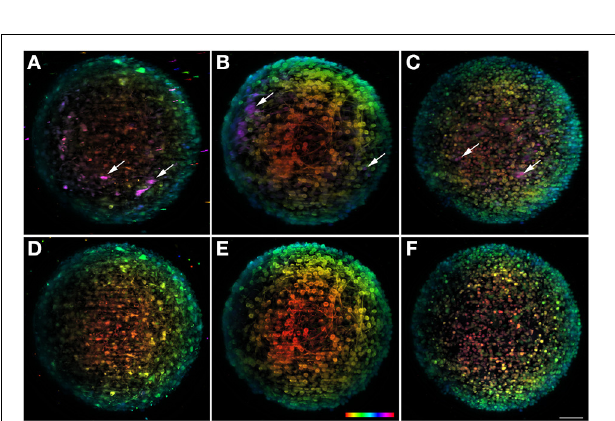
Neural aggregate #2 showing a complex dopaminergic neuron matrix at: (E) 29 μ m from surface; (F) 59 μ m and (G) 97 μ m. (H) Maximum intensity projection of the dopaminergic neuronal matrix. Sagittal views of (I) Neural aggregate #1 and (J) Neural aggregate #2. A full 3D representation of the dopaminergic neurons is shown in Movie S1 . Scale bar: 50 μ m.